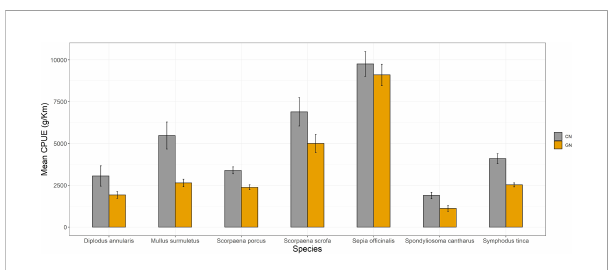
FIGURE 8 Mean catch per unit effort expressed as g/km of commercial species per commercial (CN) and modi fi ed (GN) panel,